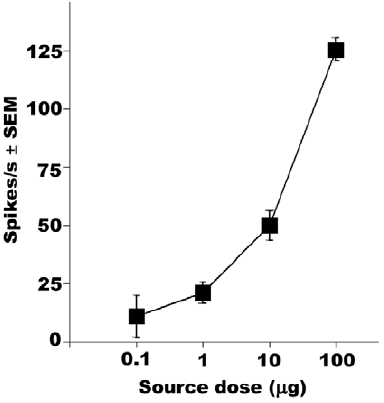
Figure 2. Dose-dependent excitatory responses from a picar- idin-sensitive ORN housed in an antennal basiconic sensillum ab3 on D.melanogaster antennae. Hexane (control) responses were subtracted. ( N =7). Error bars are standard error of the mean (SEM).